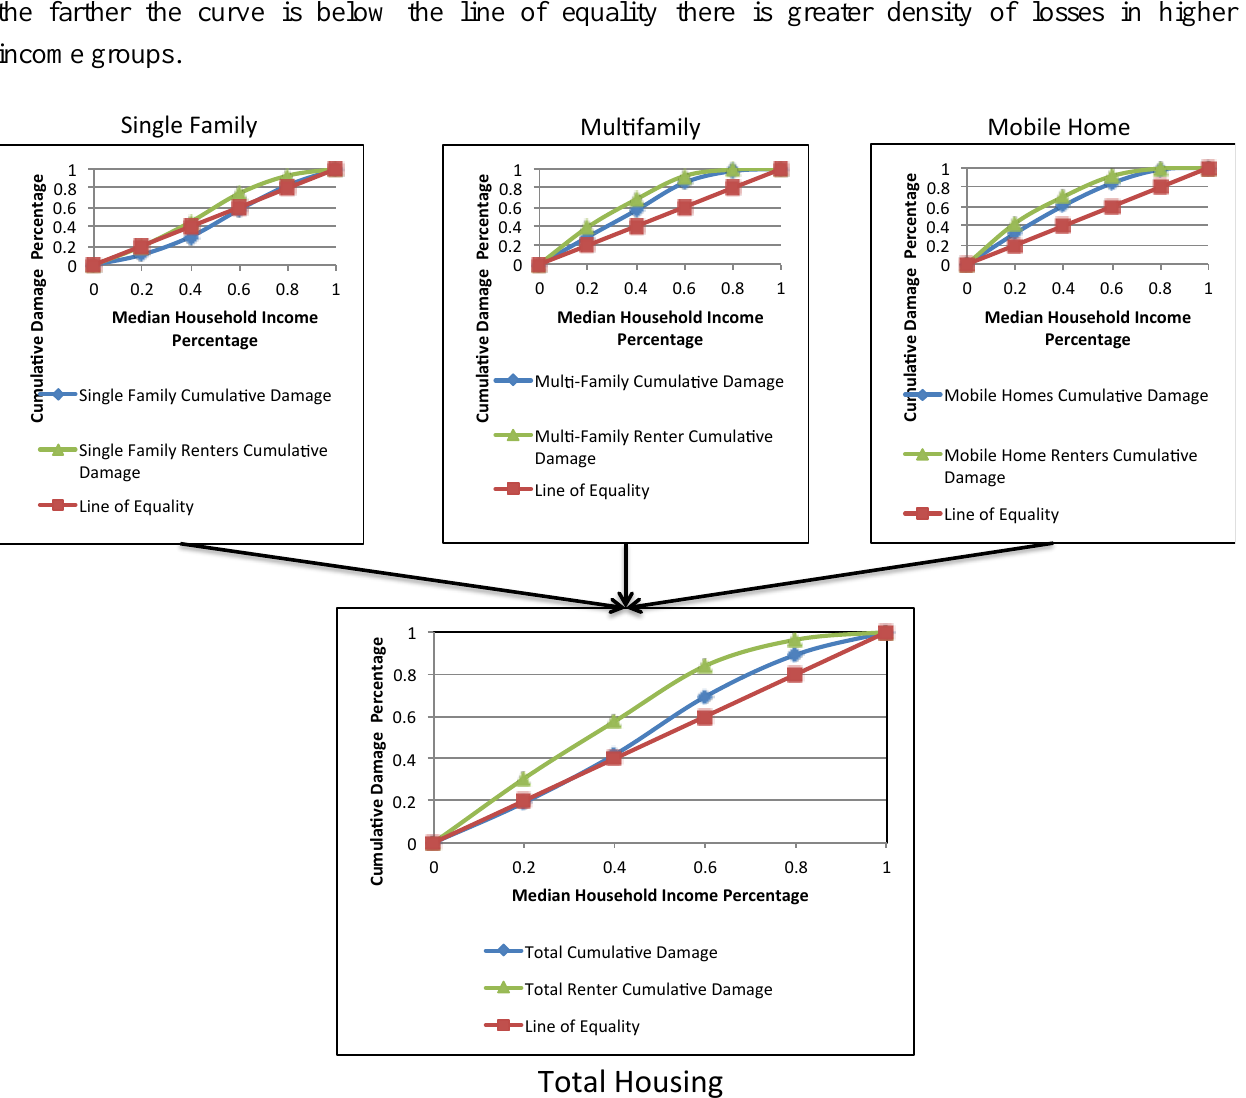
Figure 7. Earthquake risk concentration curve of cumulative damage ranked by median household income (source: